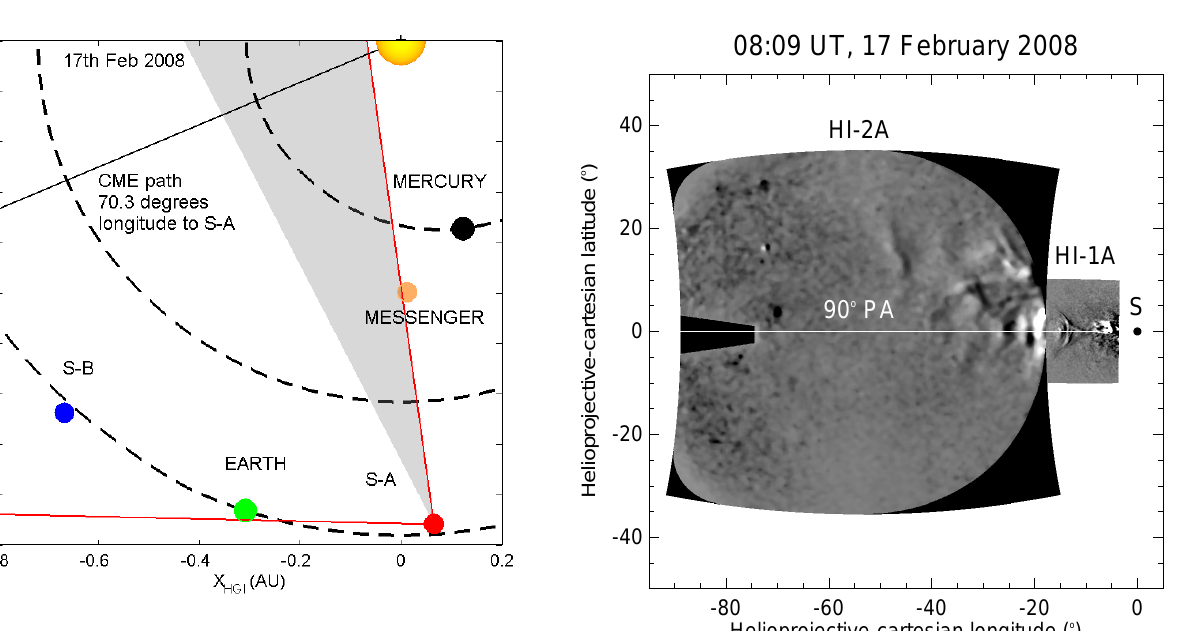
Fig. 1. The trajectories of all the spacecraft that were local to the February 2008 CME path, projected into the x-y plane in the HGI coordinate system (see main text). The orbit of Venus is displayed but the planet was positioned in another quadrant. The red lines demark the field of view of the HI cameras onboard STEREO-A, with the shaded region encompassing the field of view of HI-1.